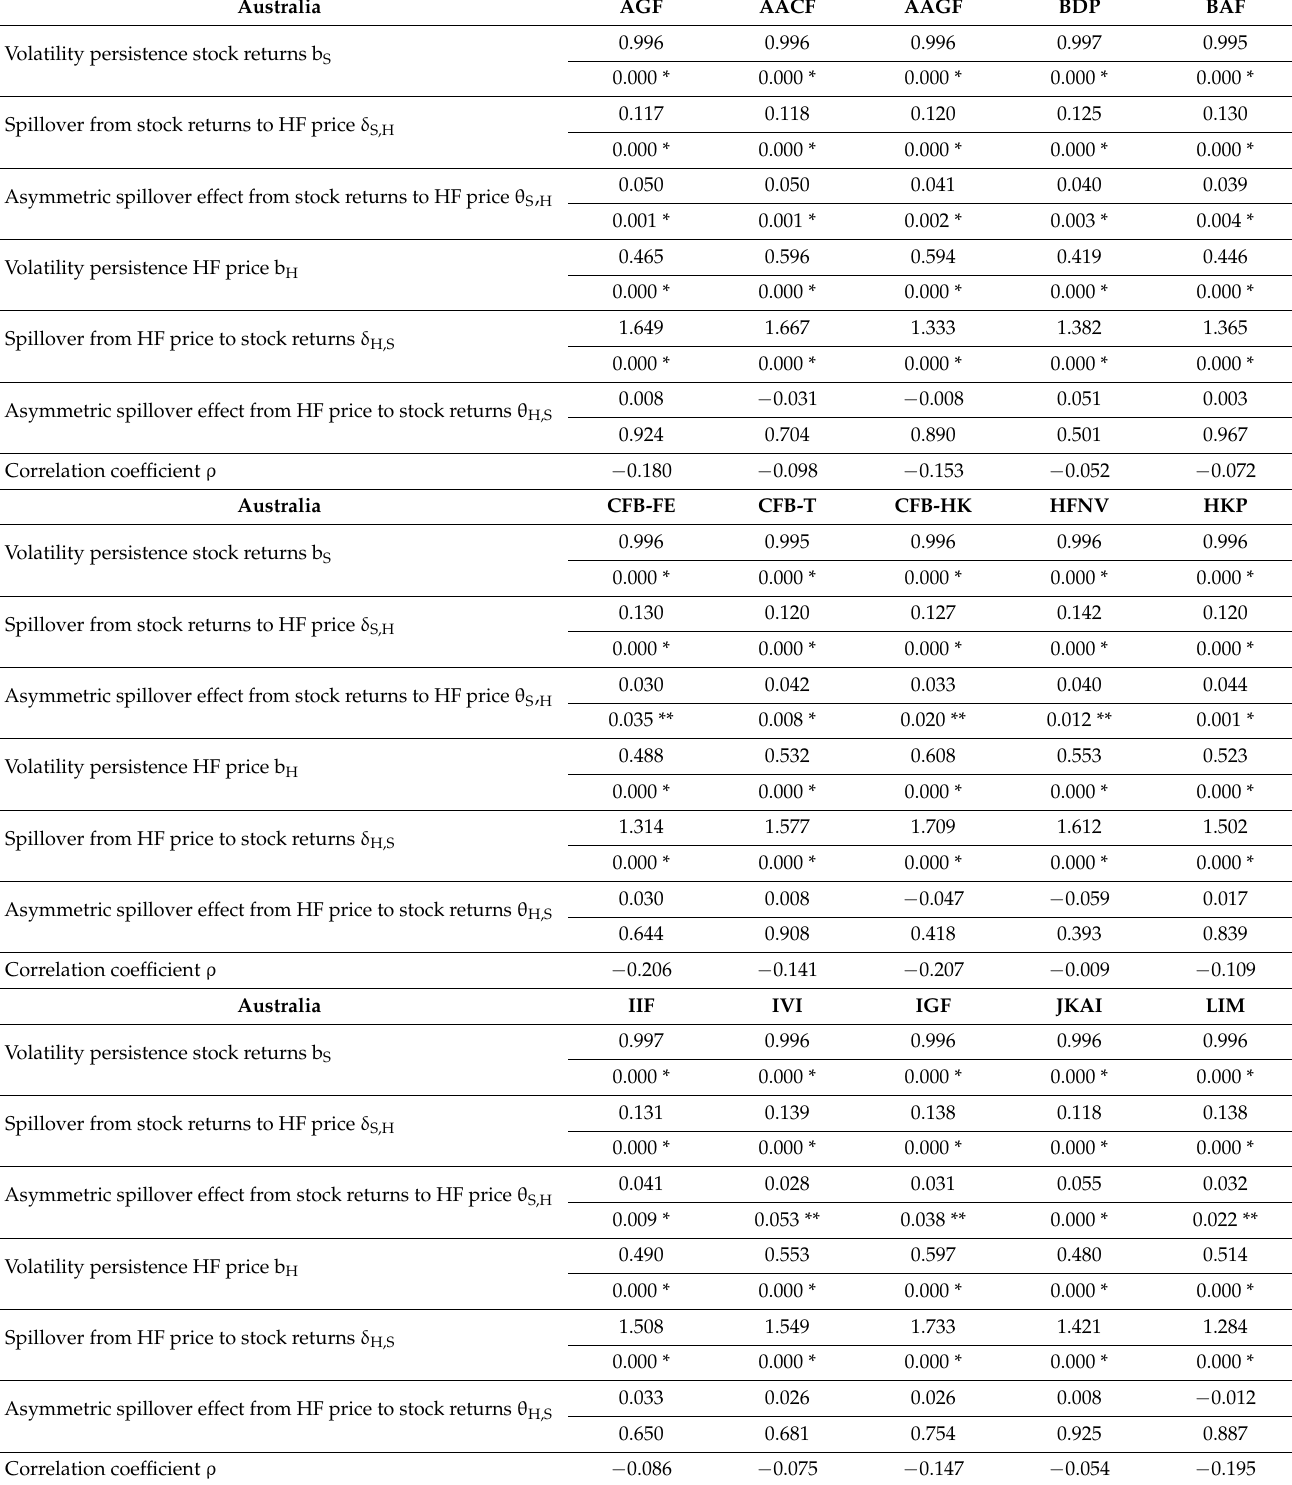
Table 2. Volatility spillover between the Australian Stock Market (ASX) and Hedge Fund